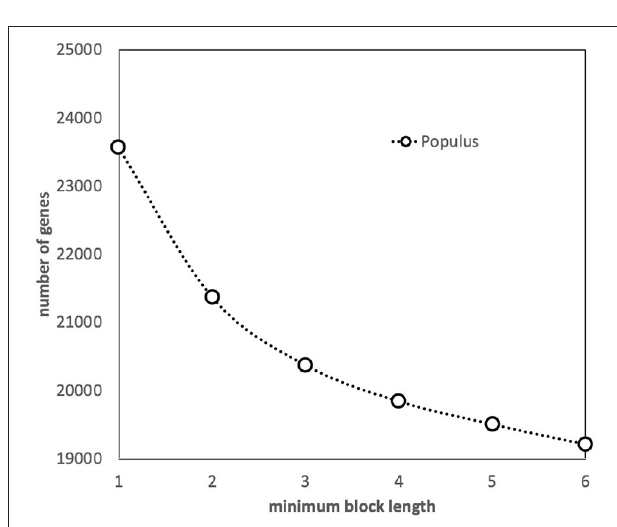
FIGURE 2 | Effect of minimum block size (number of genes) on the number of genes incorporated into synteny blocks.